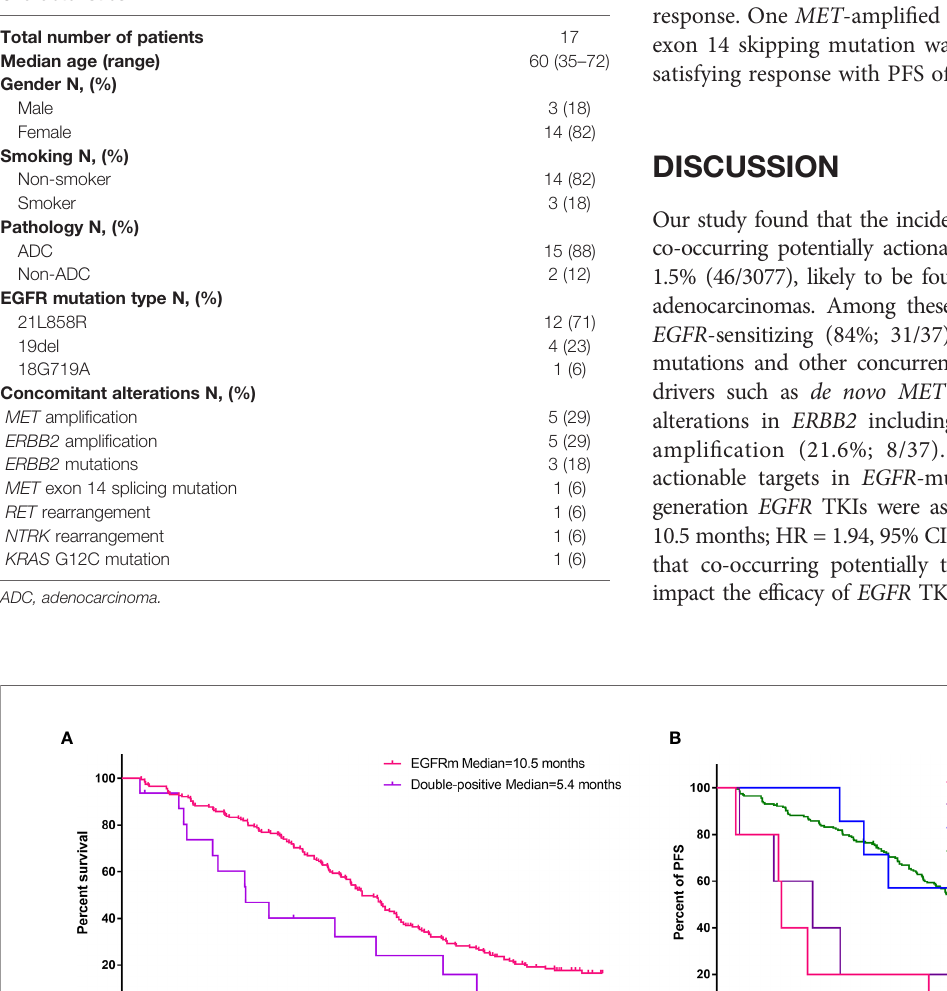
TABLE 3 | The characteristics of EGFR mutant patients harboring other potentially actionable drivers treated with fi rst-generation EGFR TKIs. Characteristics